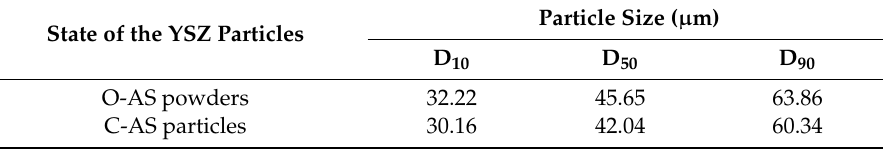
Figure 6. Particle size distribution of the O-AS powders and C-AS particles. Table 2. Particle size distribution of the O-AS powders and C-AS particles.